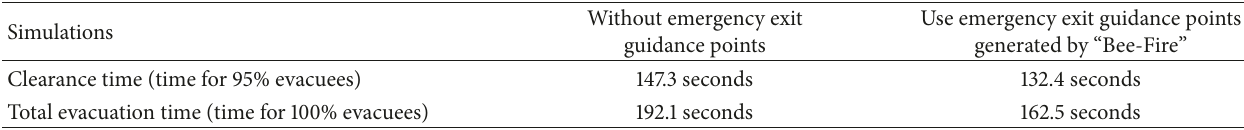
Table 8: Comparison of clearance time for both